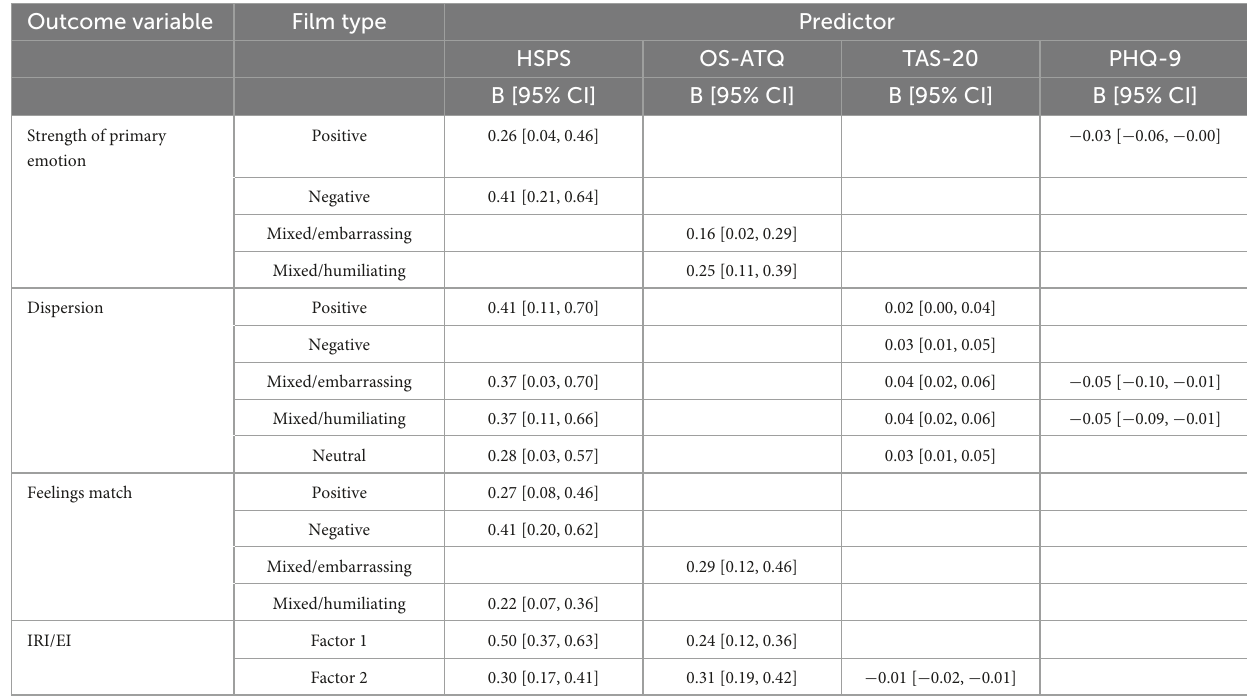
TABLE 3 Significant path coefficients for multivariate multiple regressions.